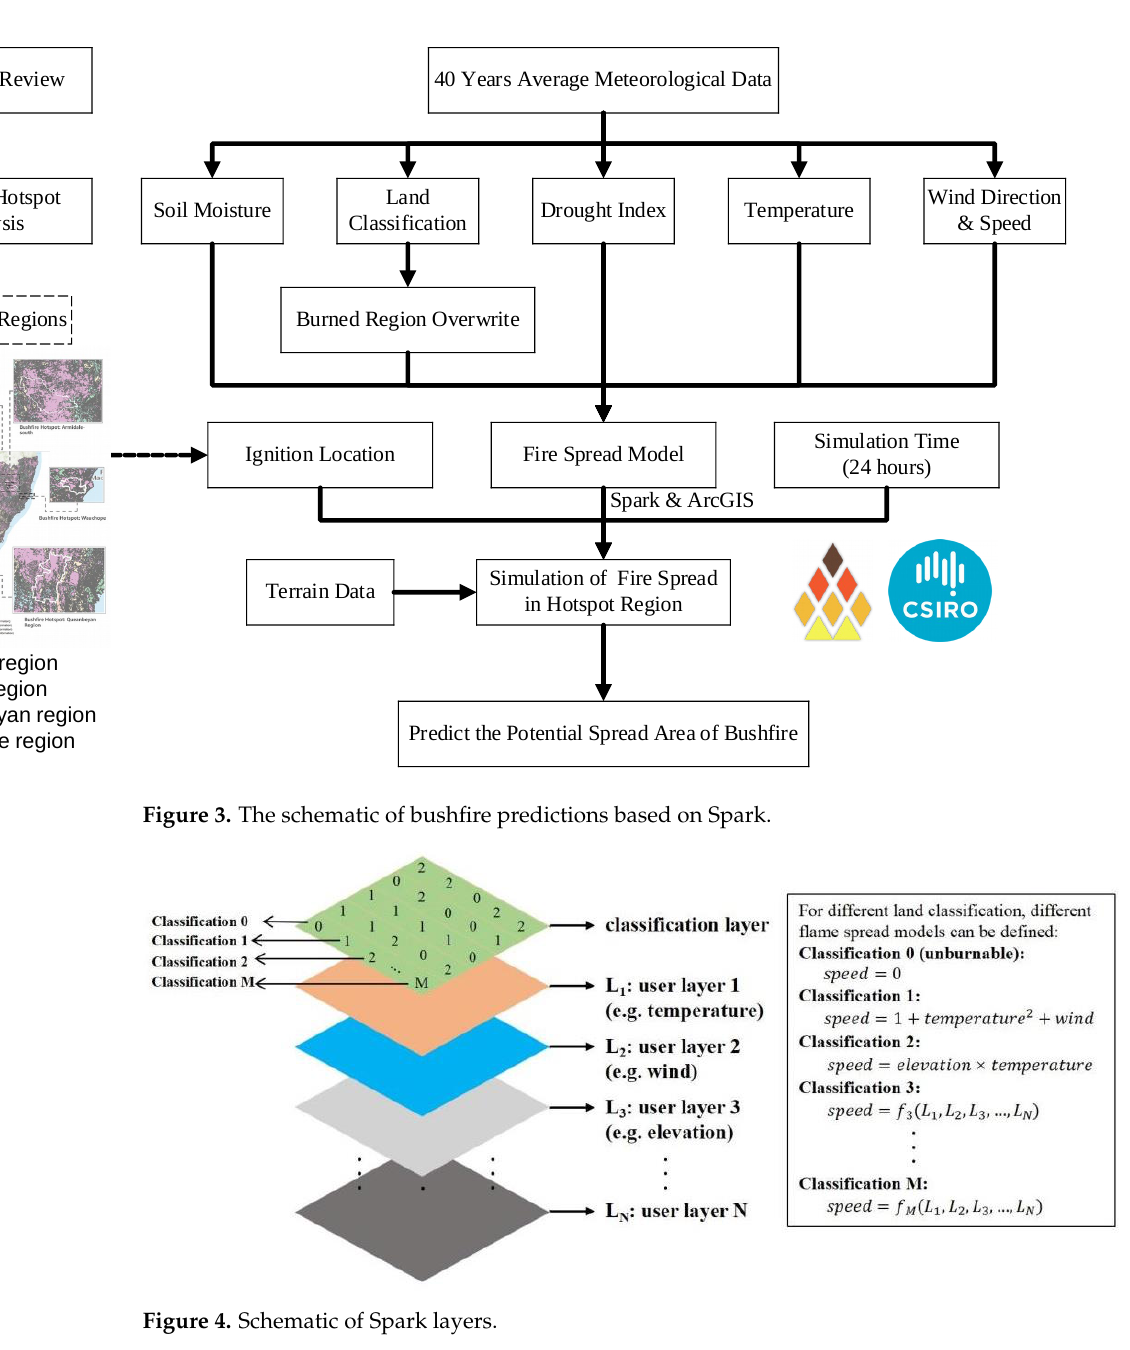
Figure 4. Schematic of Spark layers.